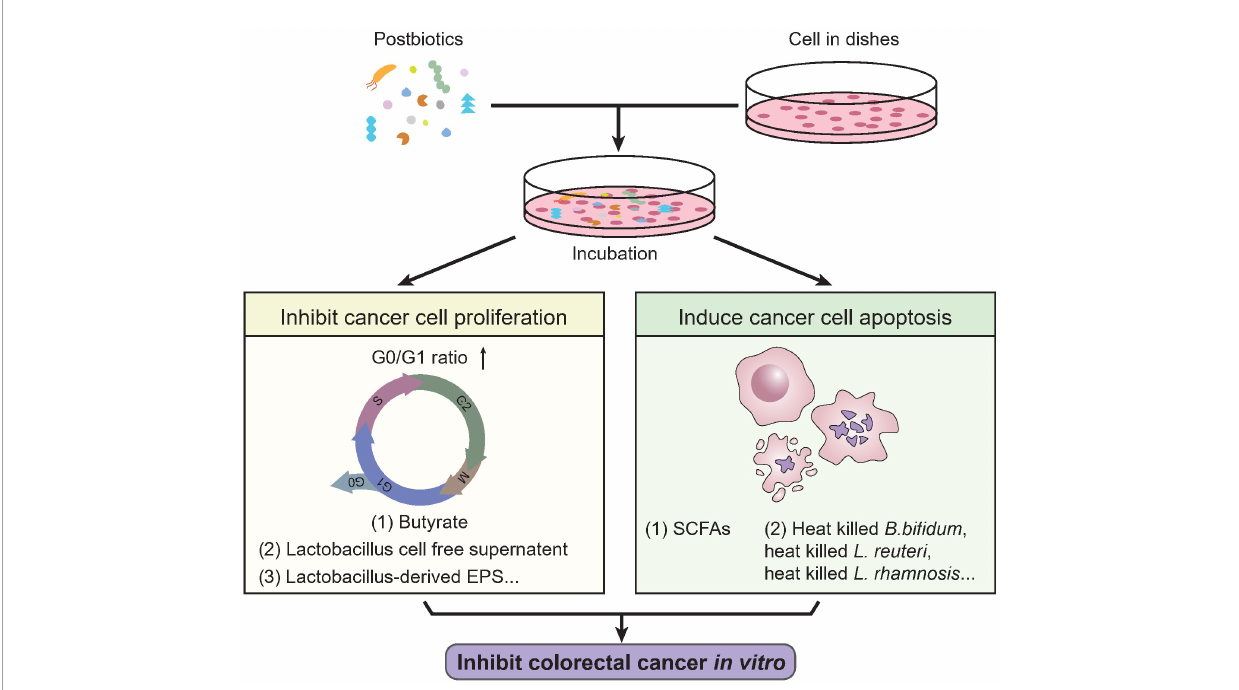
FIGURE2 In vitro activities of postbiotics against colorectal cancer. Previous studies revealed multiple biological activities of postbiotics against colorectal cancer cells in vitro . Certain types of postbiotics like butyrate, lactobacillus cell free supernatant, Lactobacillus derived EPS, etc., were shown effective in inhibiting colorectal cancer cell proliferation, characterized by cell cycle arrest (increased G0/G1 ratio and decrease in S-phase). On the other hand, SCFAs, heat-killed B. Bifidum , L. reuteri , L. rhamnosis , etc., could induce apoptosis of colorectal cancer cells. These indicate the potential biological activity of postbiotics in treating CRC. SCFAs, short chain fatty